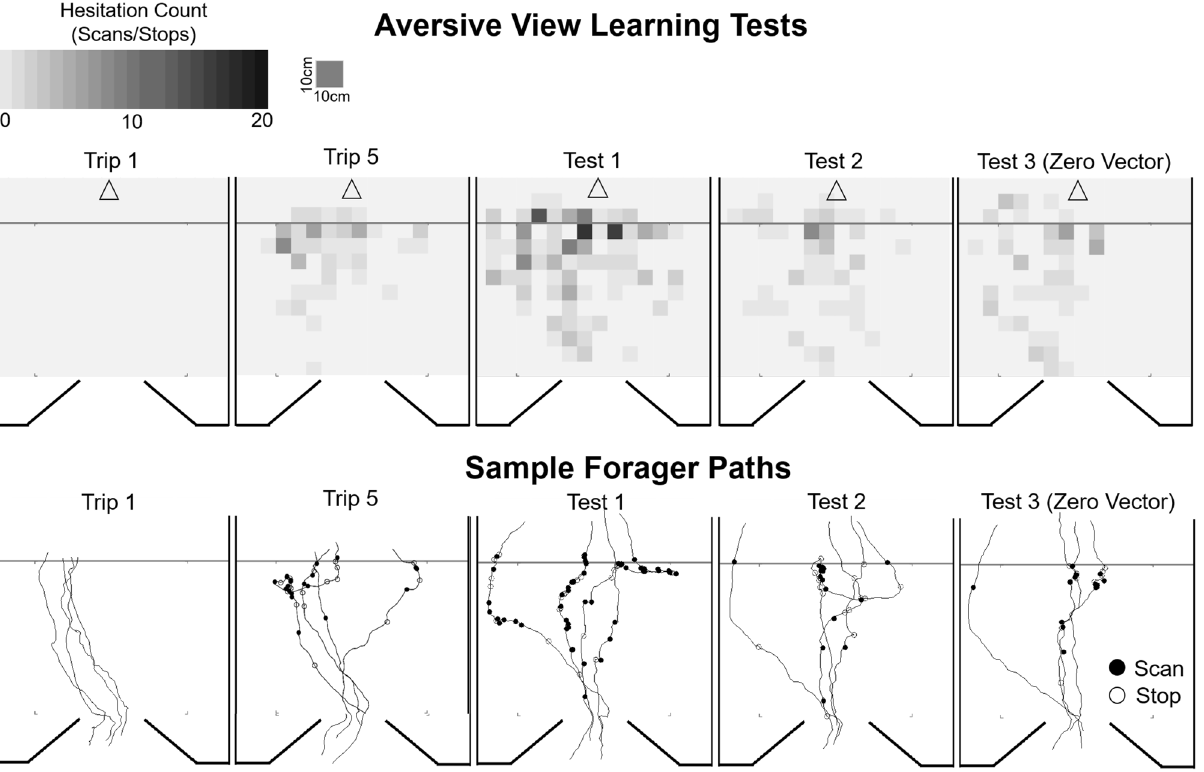
Figure 4. Heat maps of forager hesitation locations and sample paths in the Aversive Learning Tests. Heat maps of forager hesitations and five foragers’ sample paths during Trip 1, Trip 5, Test 1, Test 2 and Test 3. The nest direction is denoted by the arrow (top) for all panels and the black line crossing each heat map indicates the start of the collection area. Closed black circles denote locations of forager Scans while open circles denote Stop locations. For heat maps of hesitations for all training and test trips in the Aversive Learning tests, see SFig.